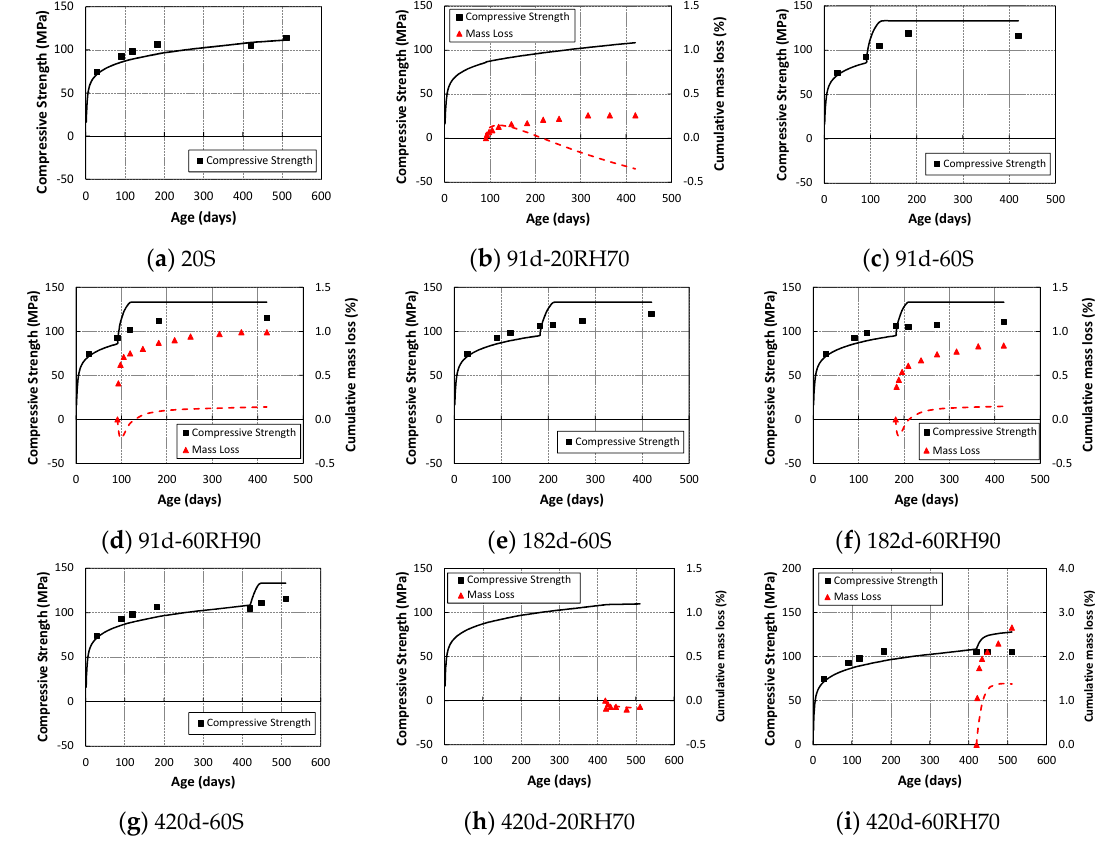
Figure 16. Comparison of compressive strength and weight loss based on the modified model (W/C = 30%) [27]. (Dot: experiment, Solid/chain line: analysis).